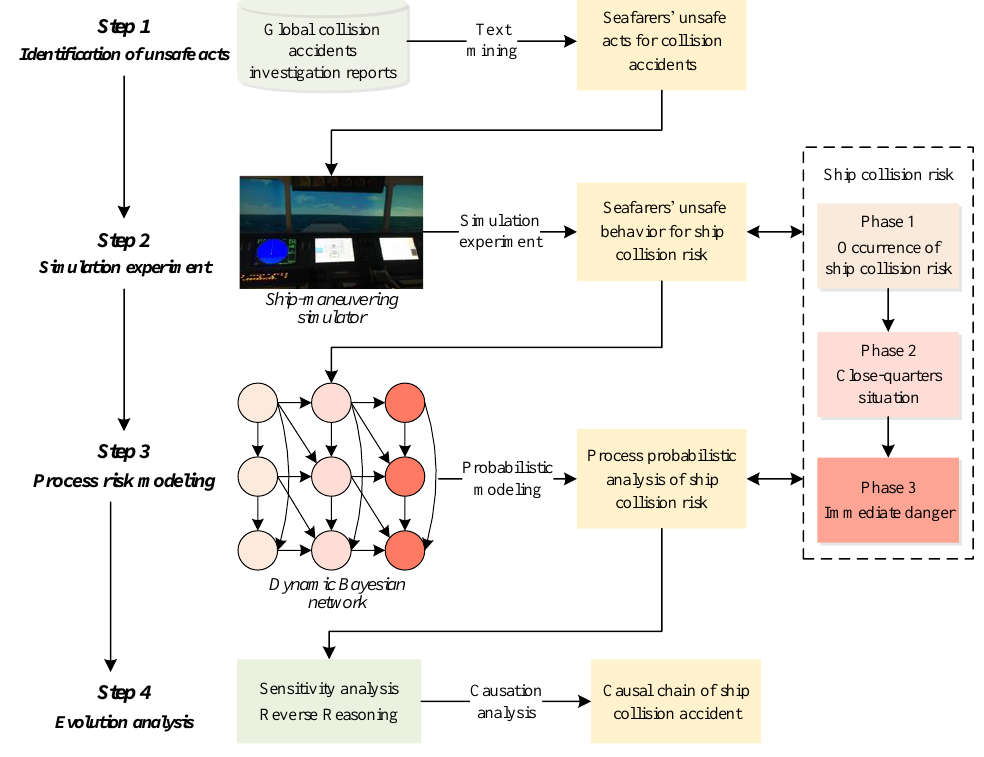
Figure 1. Research framework.